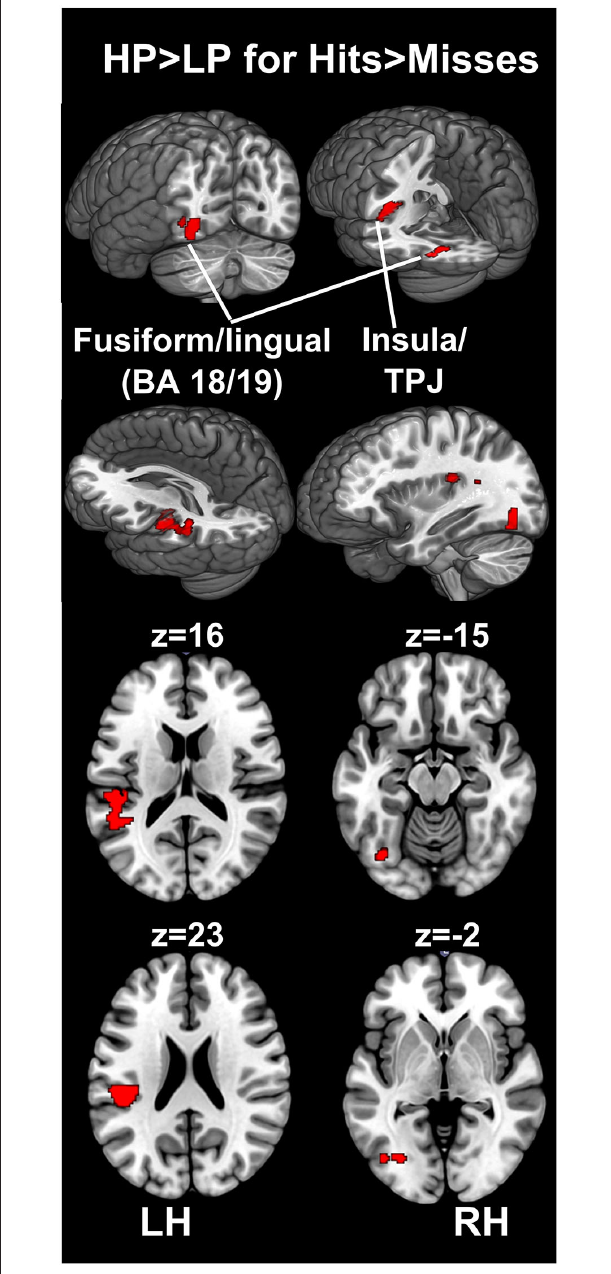
FIGURE 3 | fMRI results. The figure illustrates differences between the HP and the LP group for the contrast hits > misses. To correct for multiple comparisons, an uncorrected voxel-level threshold of p = 0.001 ( t = 3.2) was set, and in combination with a cluster-size threshold of k = 125 voxels resulted in an estimated whole-brain corrected α =5% level. The cluster-size threshold was determined using Monte Carlo simulations (10,000 iterations). Increased activity for the HP group was found in the left FFG, covering both BA 18 and 19, including parts of the fusiform and the lingual gyrus. Furthermore, increased activity for the HP group was found in the left insular cortex. This cluster covered mainly the posterior insula (BA 13) and extended towards the ventral part of the TPJ at BA 40. BA, Brodmann area; FFG, fusiform gyrus; HP, high performers; LH, left hemisphere; LP, low performers; RH, right hemisphere; TPJ, temporo-parietal junction